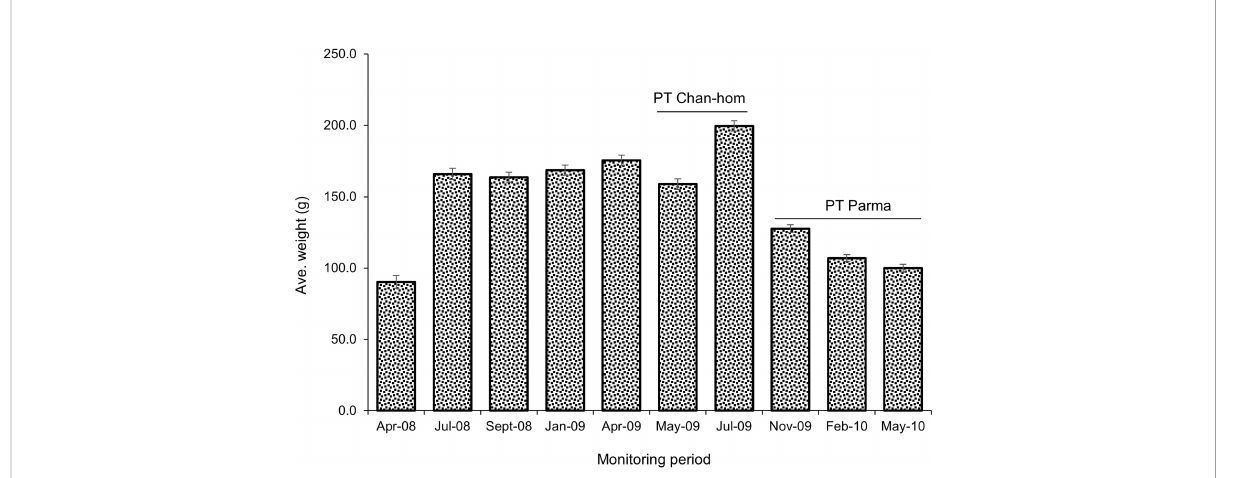
FIGURE 3 Average weight (Ave. weight ± SE) of sand fi sh across different monitoring periods before and after Typhoons Chan-hom and Parma hit Bolinao, Northwestern Philippines in May and September 2009,